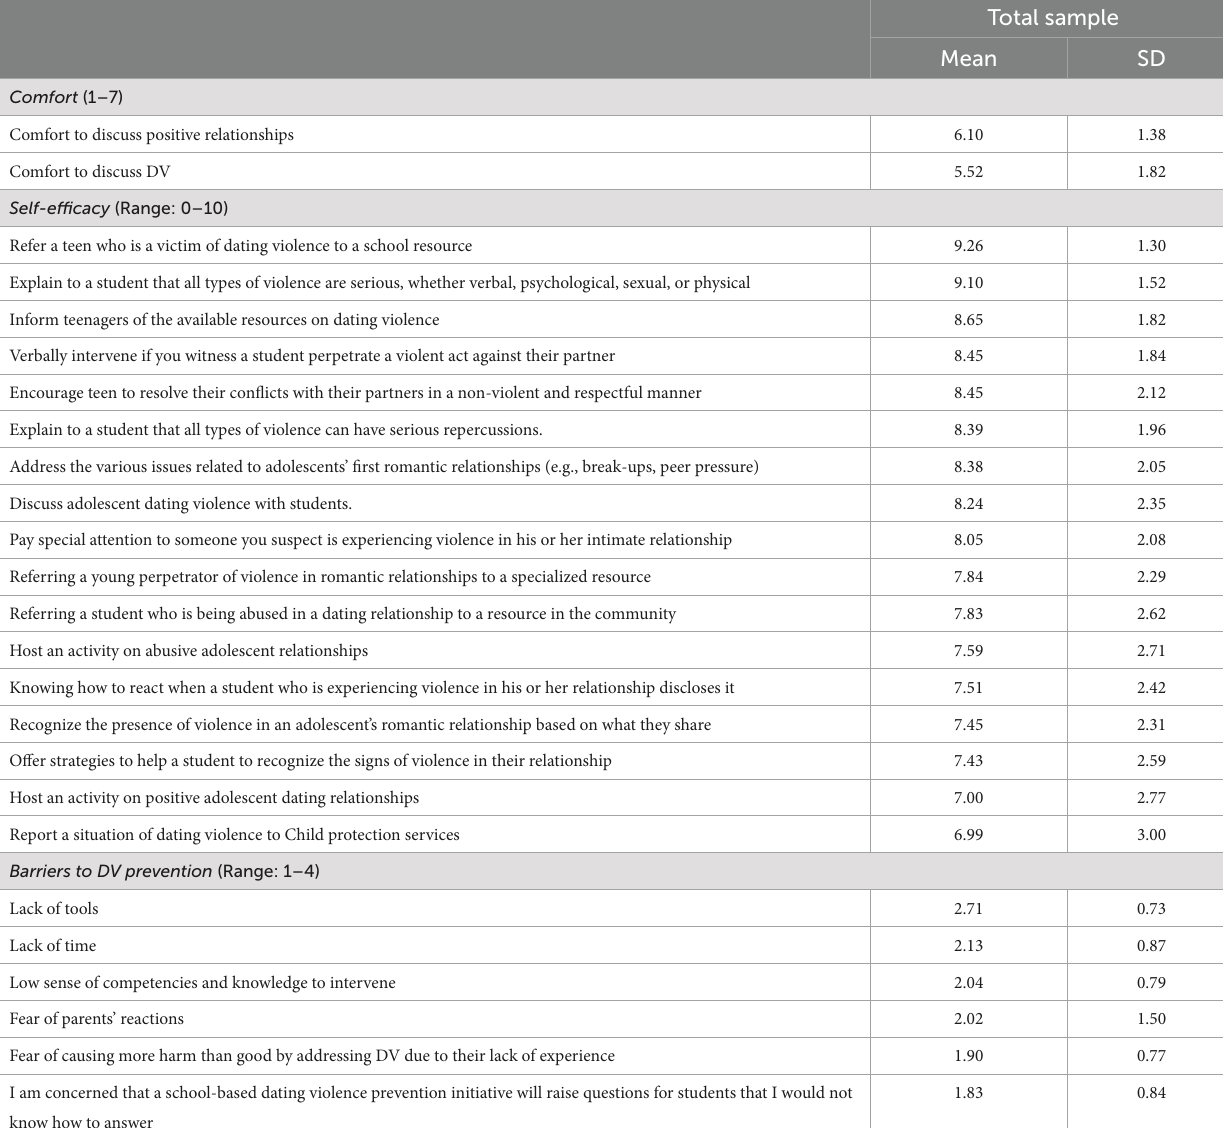
TABLE 2 Comfort, self-efficacy, and barriers to DV prevention among school